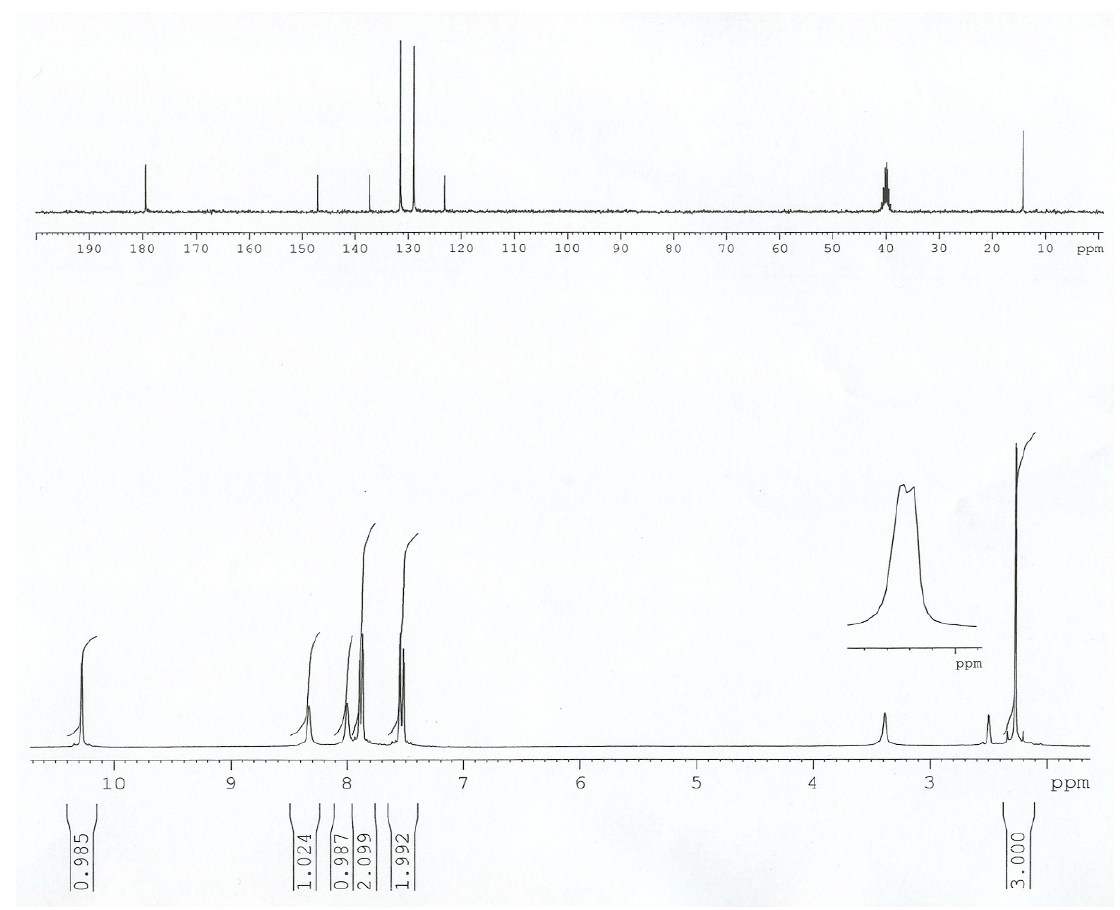
Figure 2. 1 H and 13 C NMR spectrum of ( E )-4-bromoacetophenone thiosemicarbazone ( III ) in DMSO-d